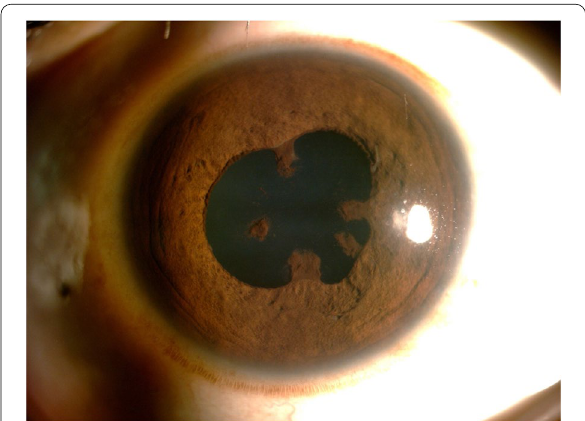
Fig. 1 Slit-lamp photograph of right eye spill over anterior uveitis with broad-based posterior synechiae